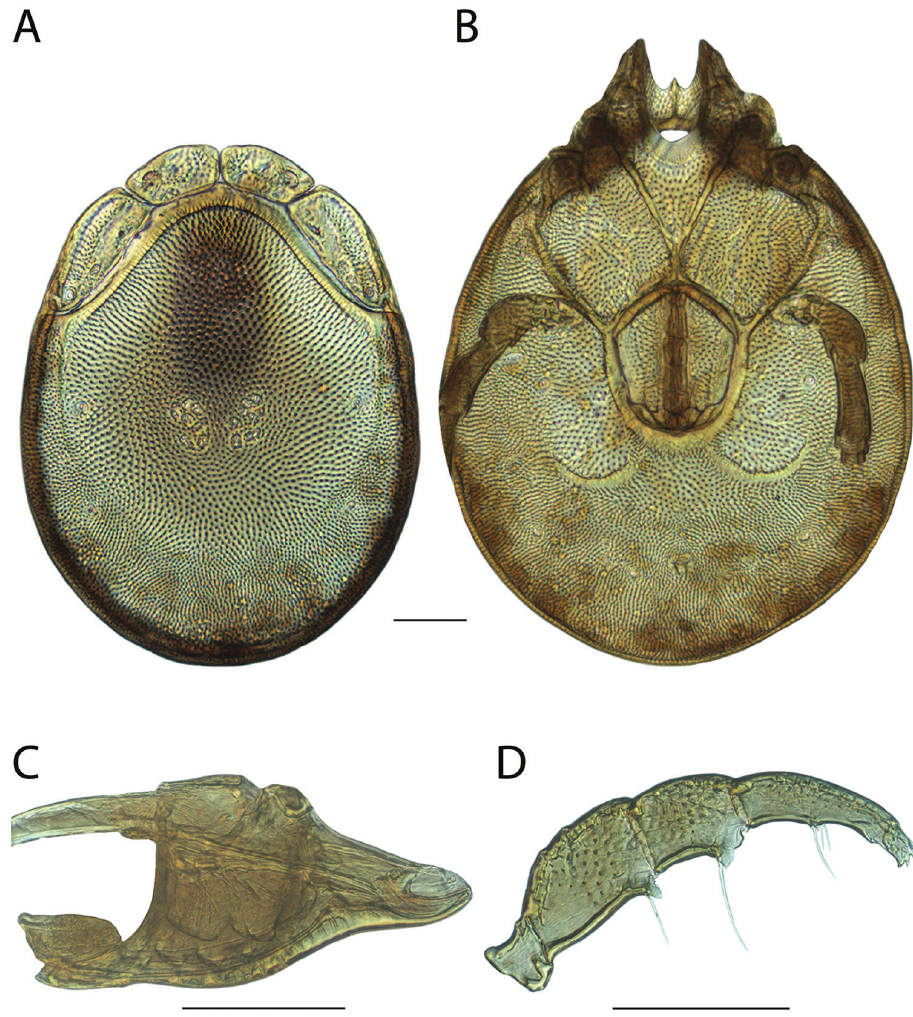
Figure 153. Torrenticola mohawk sp. n. female: A dorsal plates B venter (legs removed) C subcapitulum D pedipalp (setae not accurately depicted). Scale = 100